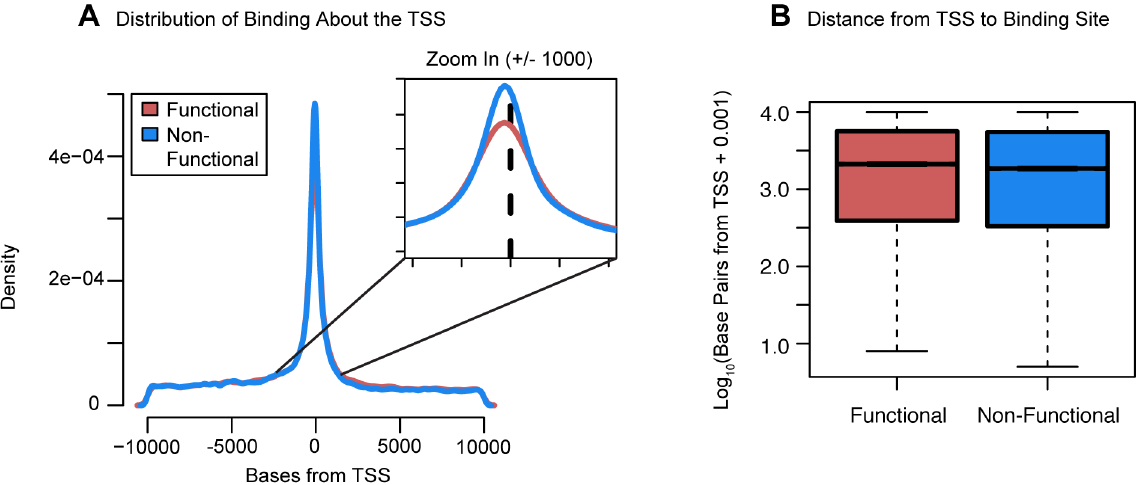
Figure 5. Distribution of functional binding about the TSS. (a) A density plot of the distribution of bound sites within 10 kb of the TSS for both functional and non-functional genes. Inset is a zoom-in of the region + / 2 1 kb from the TSS (b) Boxplots comparing the distances from the TSS to the binding sites for functionally bound genes and non-functionally bound genes. For the boxplots, 0.001 was added before log10 transforming the distances and outliers were not plotted.